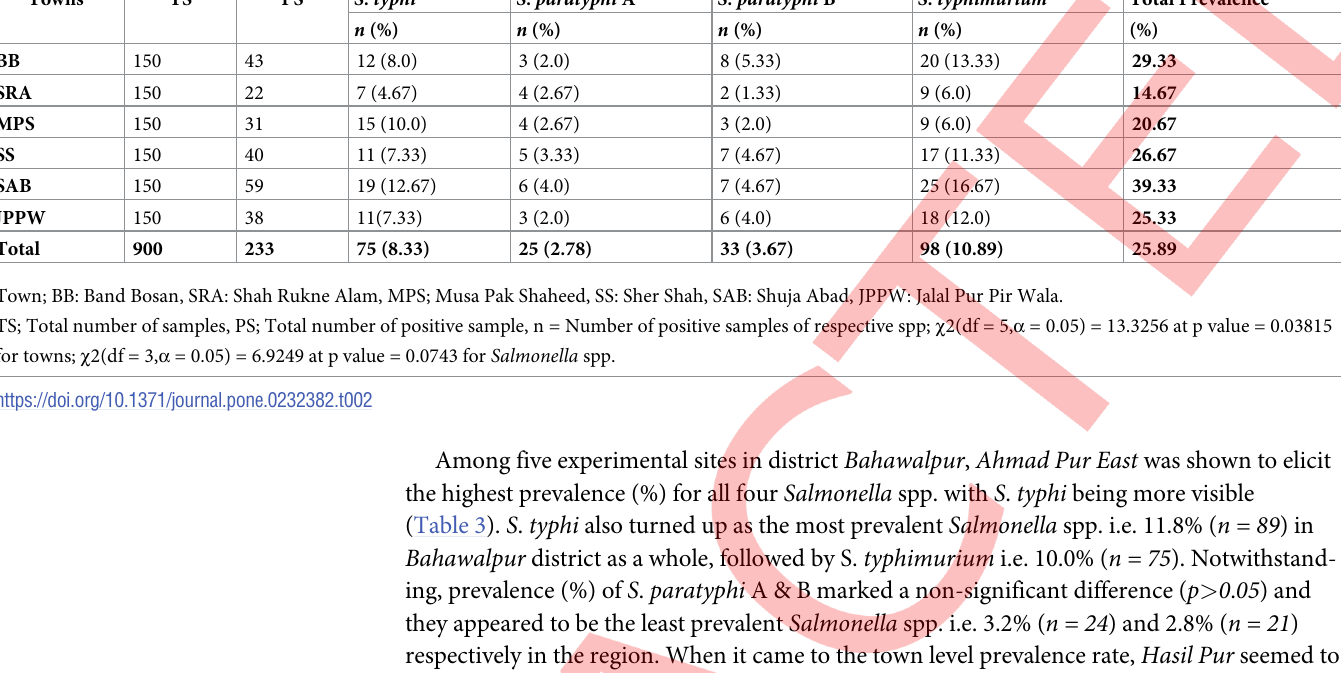
Table 2. Prevalence (%) of Salmonella spp. isolated from raw milk and environment samples in dairy farms from district Multan . Towns TS